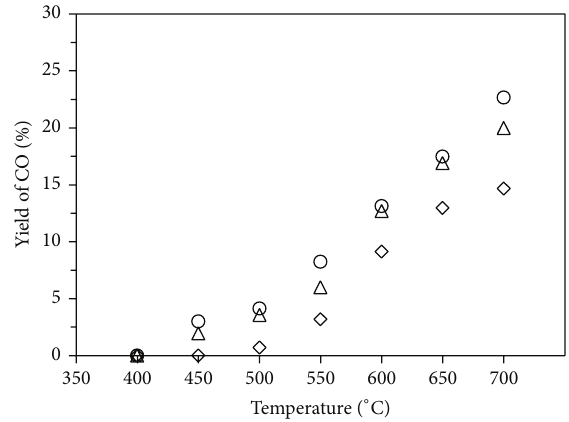
= 𝑃 = 1 kPa, balance H 2 CO 2